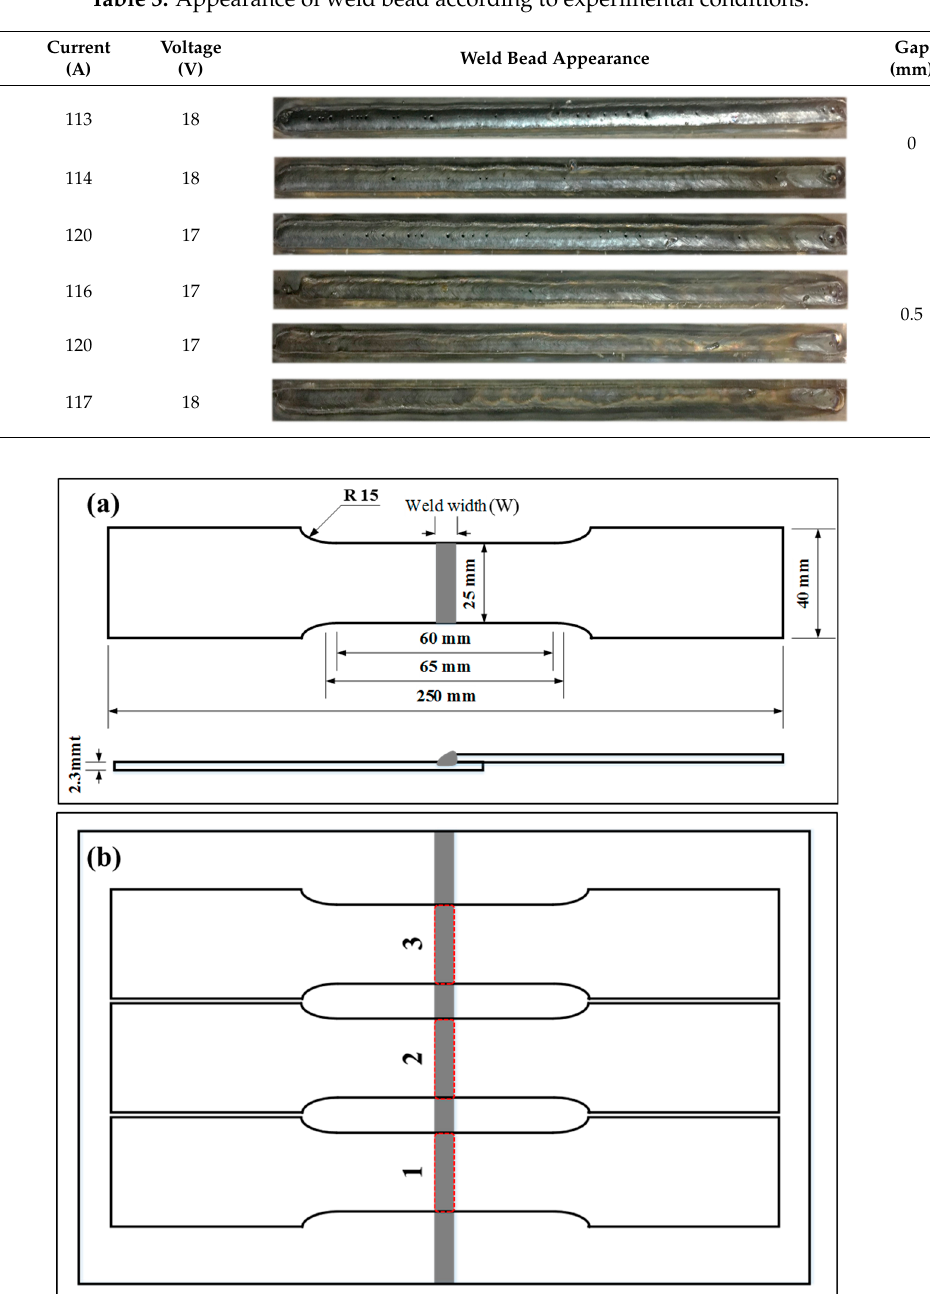
Figure 3. Specifications of the tensile test specimen for weldability evaluation: ( a ) tensile test specimen size; ( b ) tensile test specimen processing method.